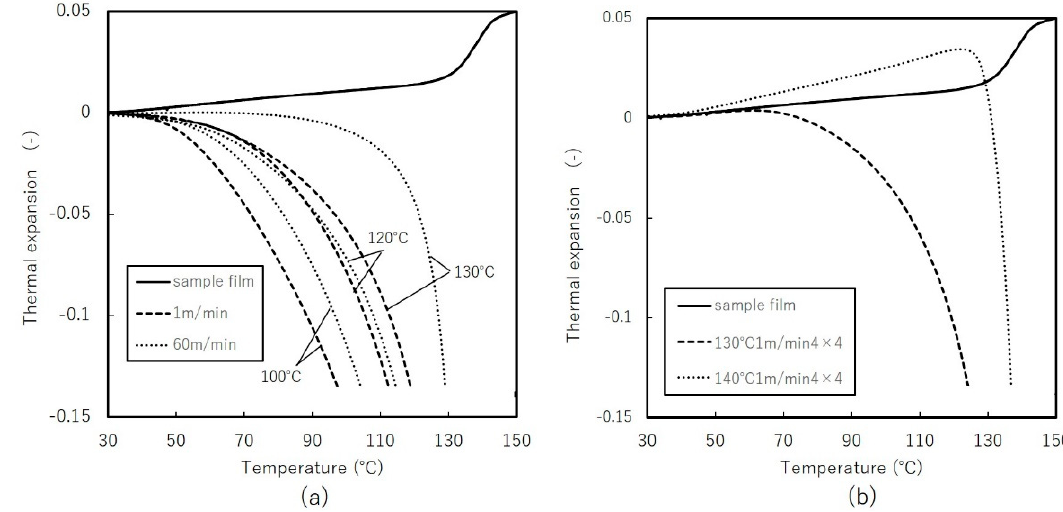
Figure 14. Thermal mechanical analysis of: ( a ) uniaxially free-width ( b ) simultaneous biaxially stretched films.